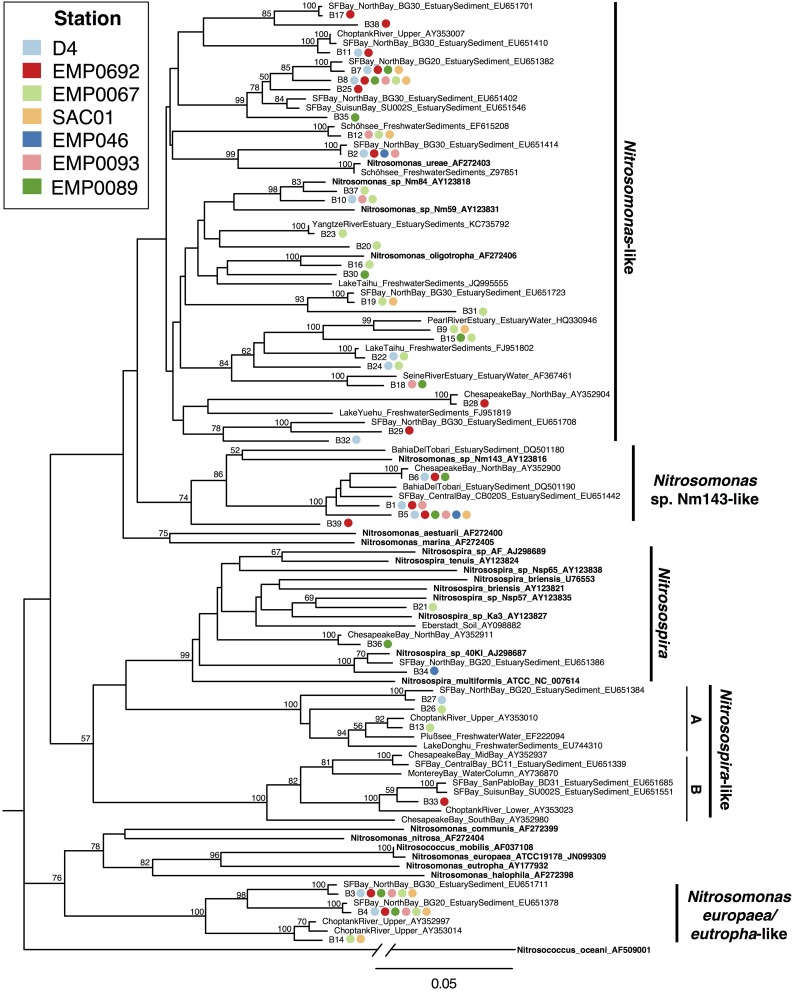
Neighbor joining tree of AOB amoA OTUs (≥95% similarity) from the Delta. Colored points next to each OTU indicate the composition of the OTU by station. Values at nodes indicate bootstrap support ≥50% (1000 neighbor-joining bootstrap replicates). Reference sequences from named organisms are indicated in bold. Clades referred to in the text are marked to the right of the tree.